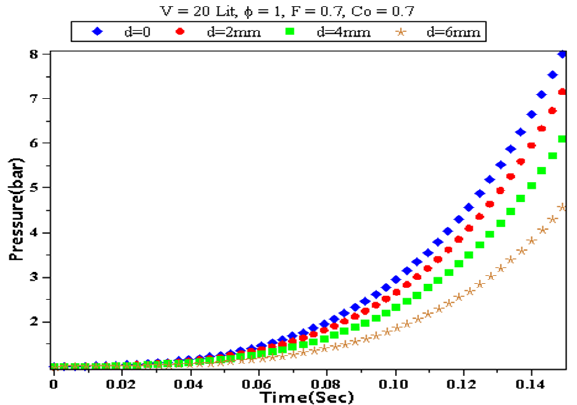
Fig. 6. Effect of Fuel concentration and radiation on flame prop - agation.